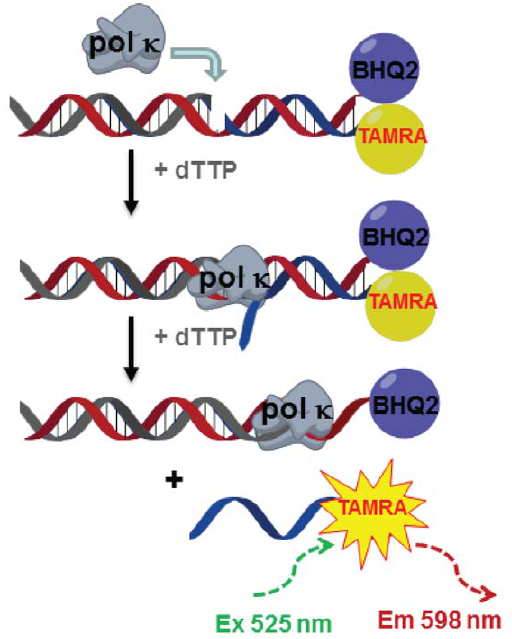
Figure 1. Principle of the fluorescence-based polymerase- catalyzed strand displacement assay. Pol k -catalyzed DNA synthesis displaces TAMRA-labeled reporter strand. This process relieves the quenching effect of BHQ-2, leading to an increase in fluorescence signals.